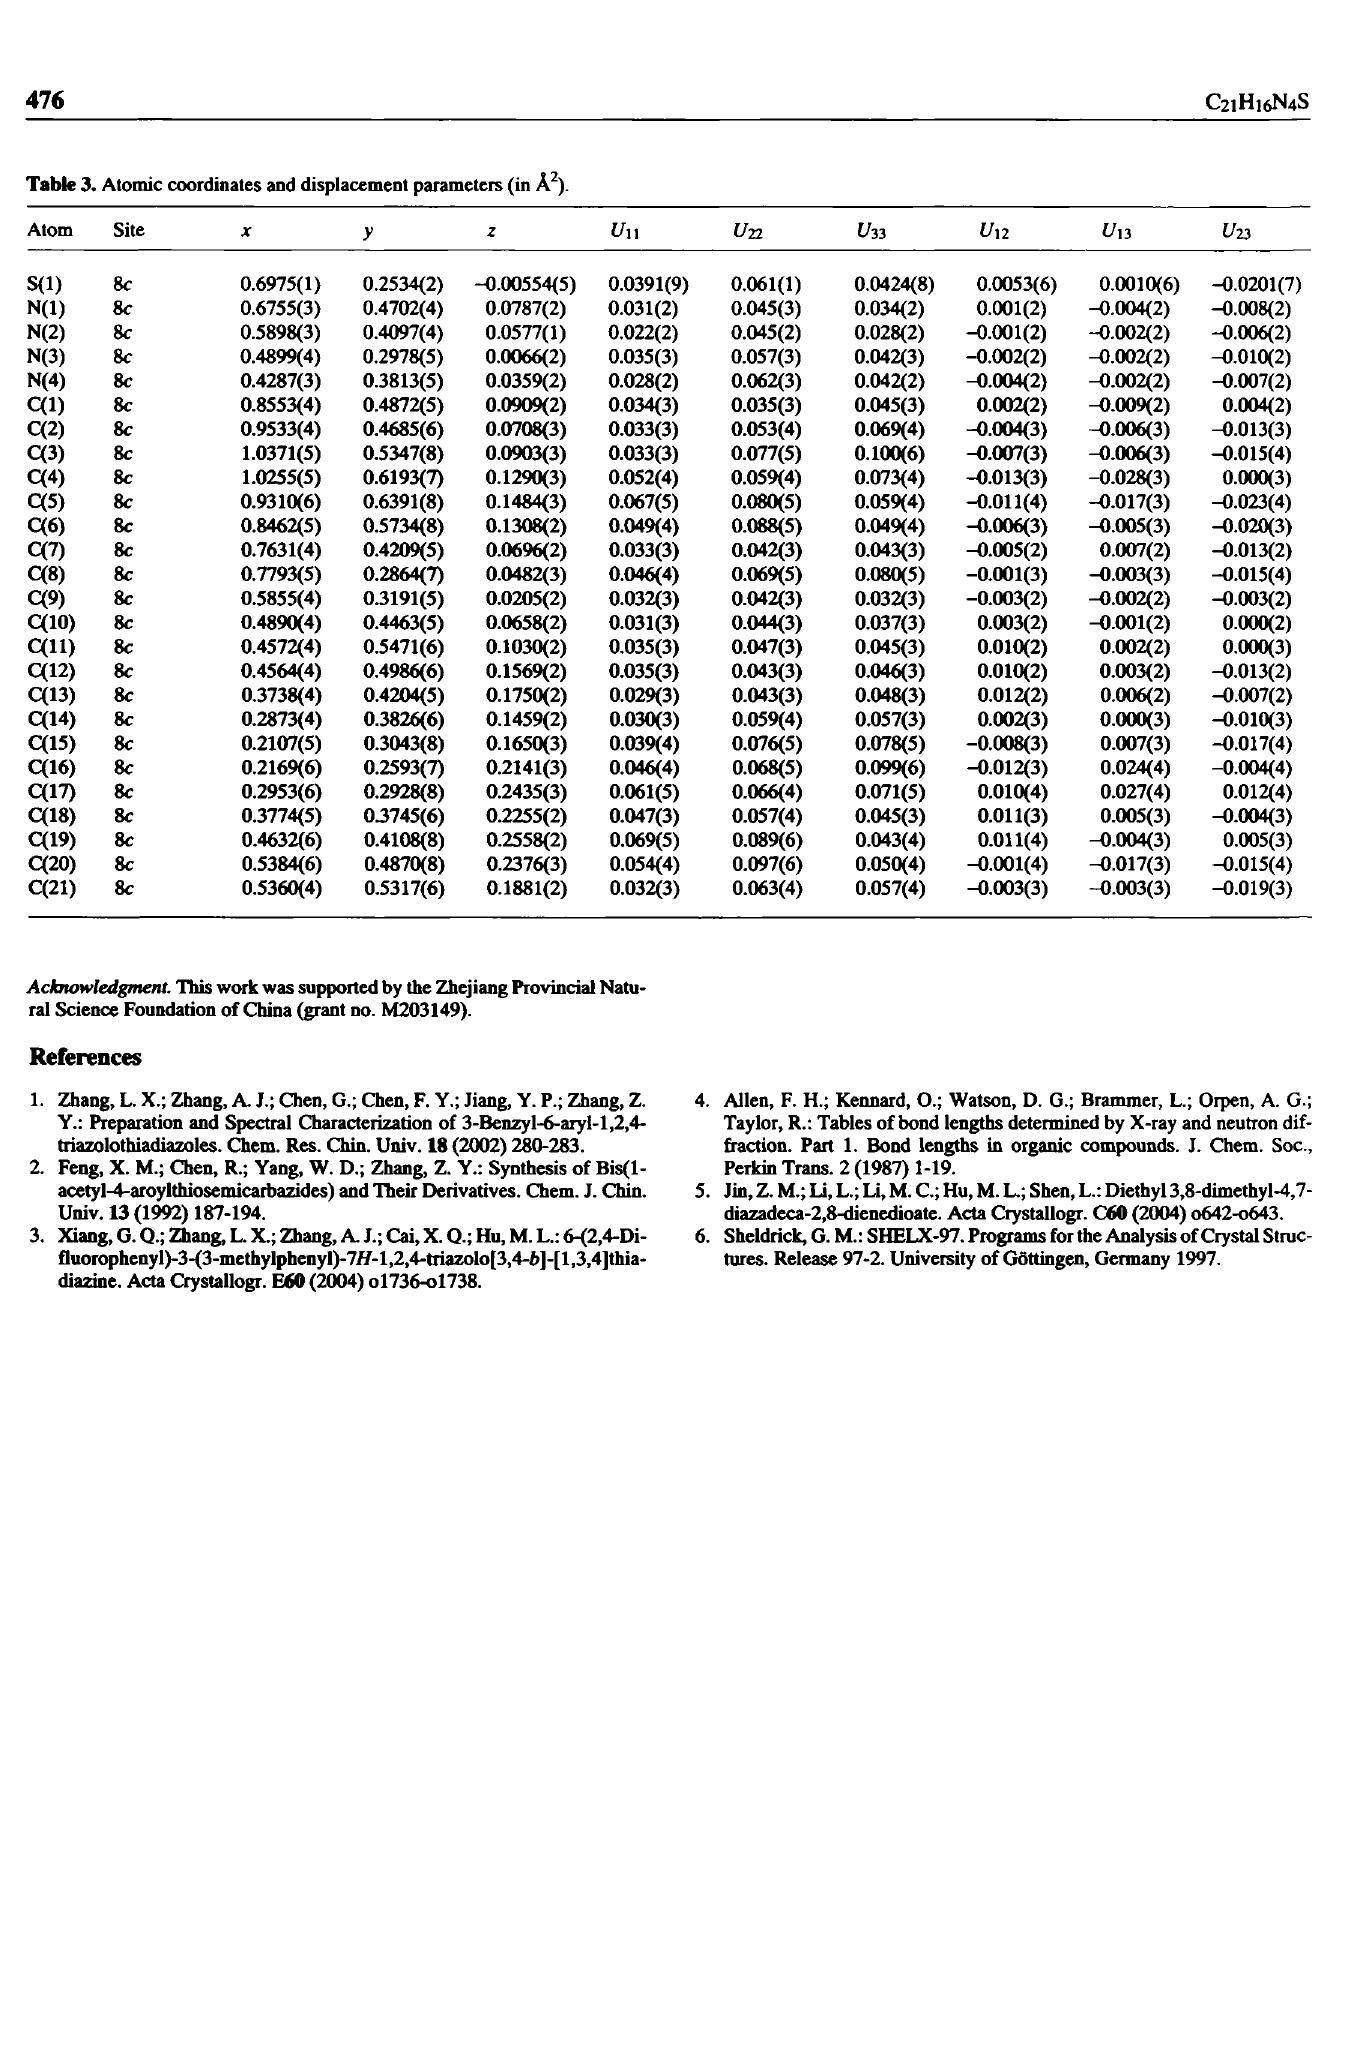
Table 3. Atomic coordinates and displacement parameters (in A 2